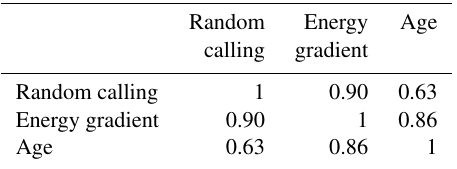
Table 5. Correlation coefficient among scheduling methods for Layer